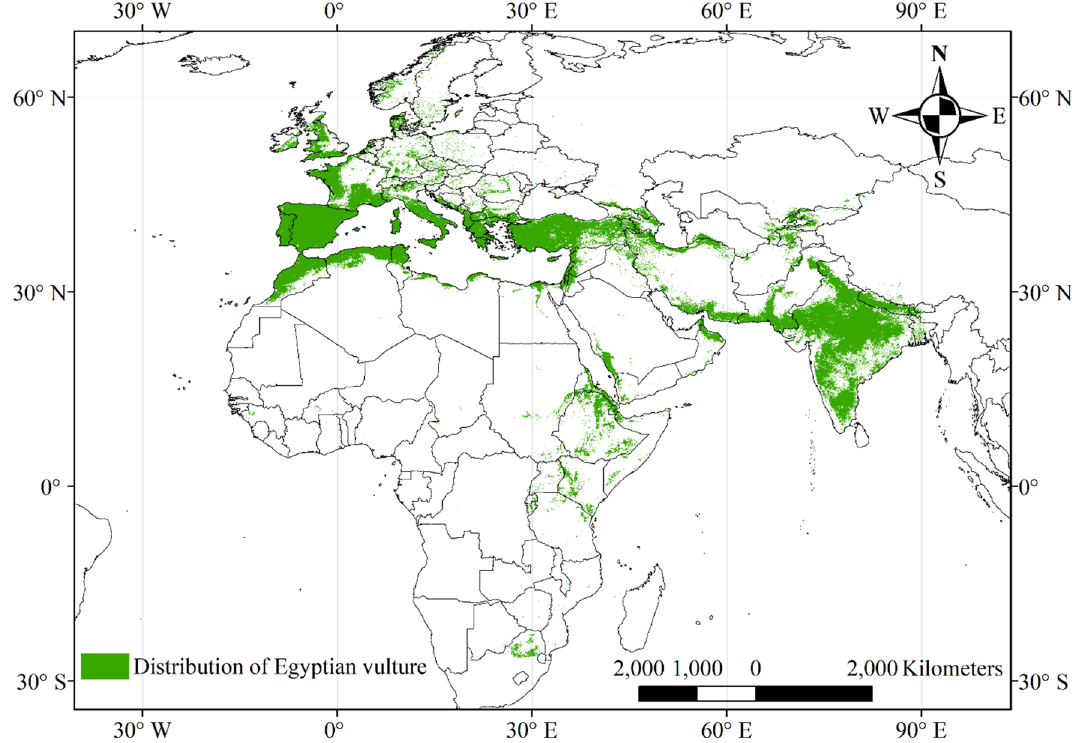
Figure 4. Predicted suitable global habitat range for the Egyptian vulture based on MaxEnt modelling of 4740 occurrence data points from observations across all seasons and 16 environmental